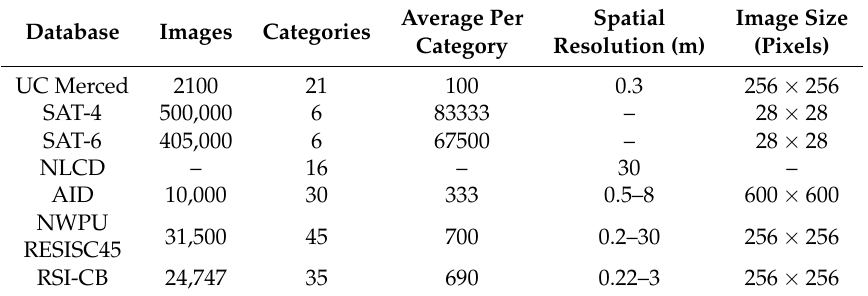
Table 5. Comparison of RSI-CB with existing remote sensing data sets Nationla Land Cover Database (NLCD) database records pixels as categories, which is different from the recent database form). AID = aerial image data set; NWPU = Northwestern Polytechnic University